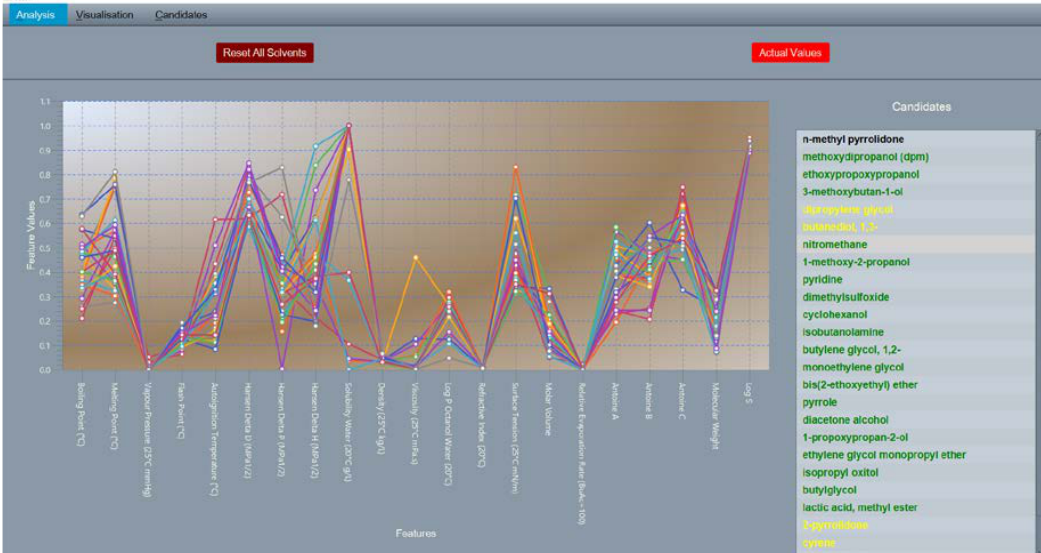
Figure 11. Visualization of candidates list in SUSSOL software. View can be switched between normalized and actual values. The candidate list in the screenshot is not complete. In the software, the scroll bar can be used to view the complete list. Protic solvents are still present in the list in the screenshot.